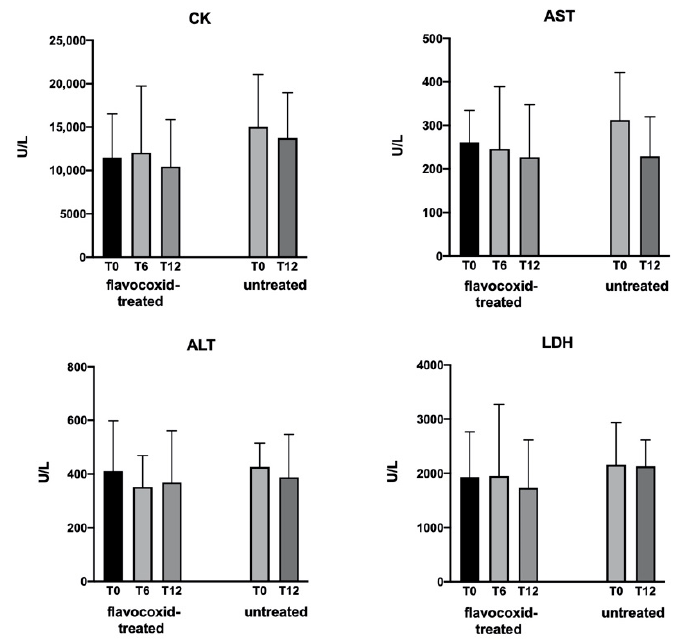
Figure 2. Levels of serum creatine kinase (CK), aspartate aminotransferase (AST), alanine amino- transferase (ALT), and lactate dehydrogenase (LDH) measured in patients at baseline (T0) and after 6 and 12 months (T6 and T12, respectively) of treatment with flavocoxid, and in untreated controls at T0 and T12. Data expressed as mean ± SD. There were no significant differences within groups versus T0.